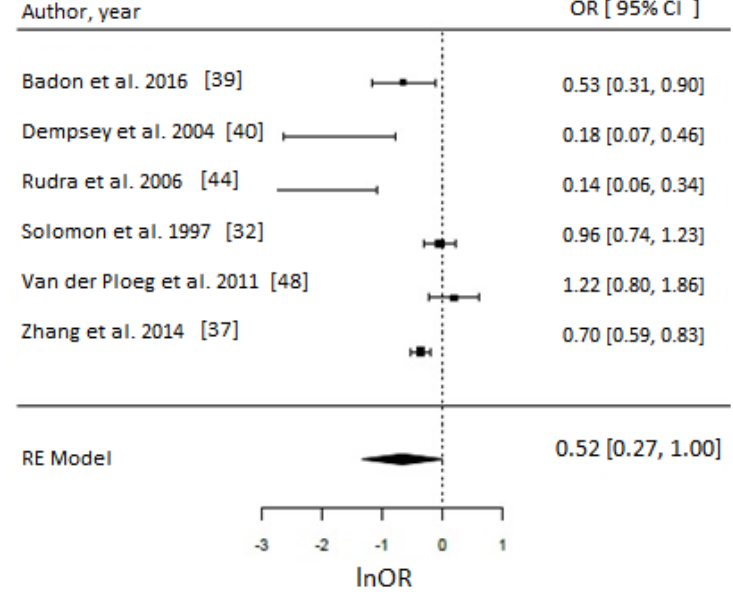
11 of 19 ( B ) Figure 4. Metaanalysis of participation in high versus low level of leisure time physical activity